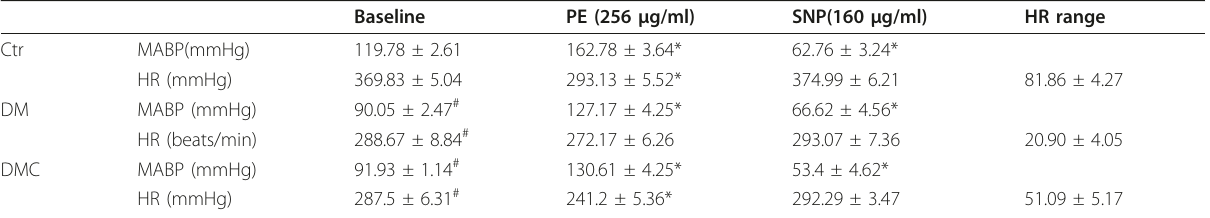
Table 1 Arterial blood pressure and HR before and after PE and/or SNP administration